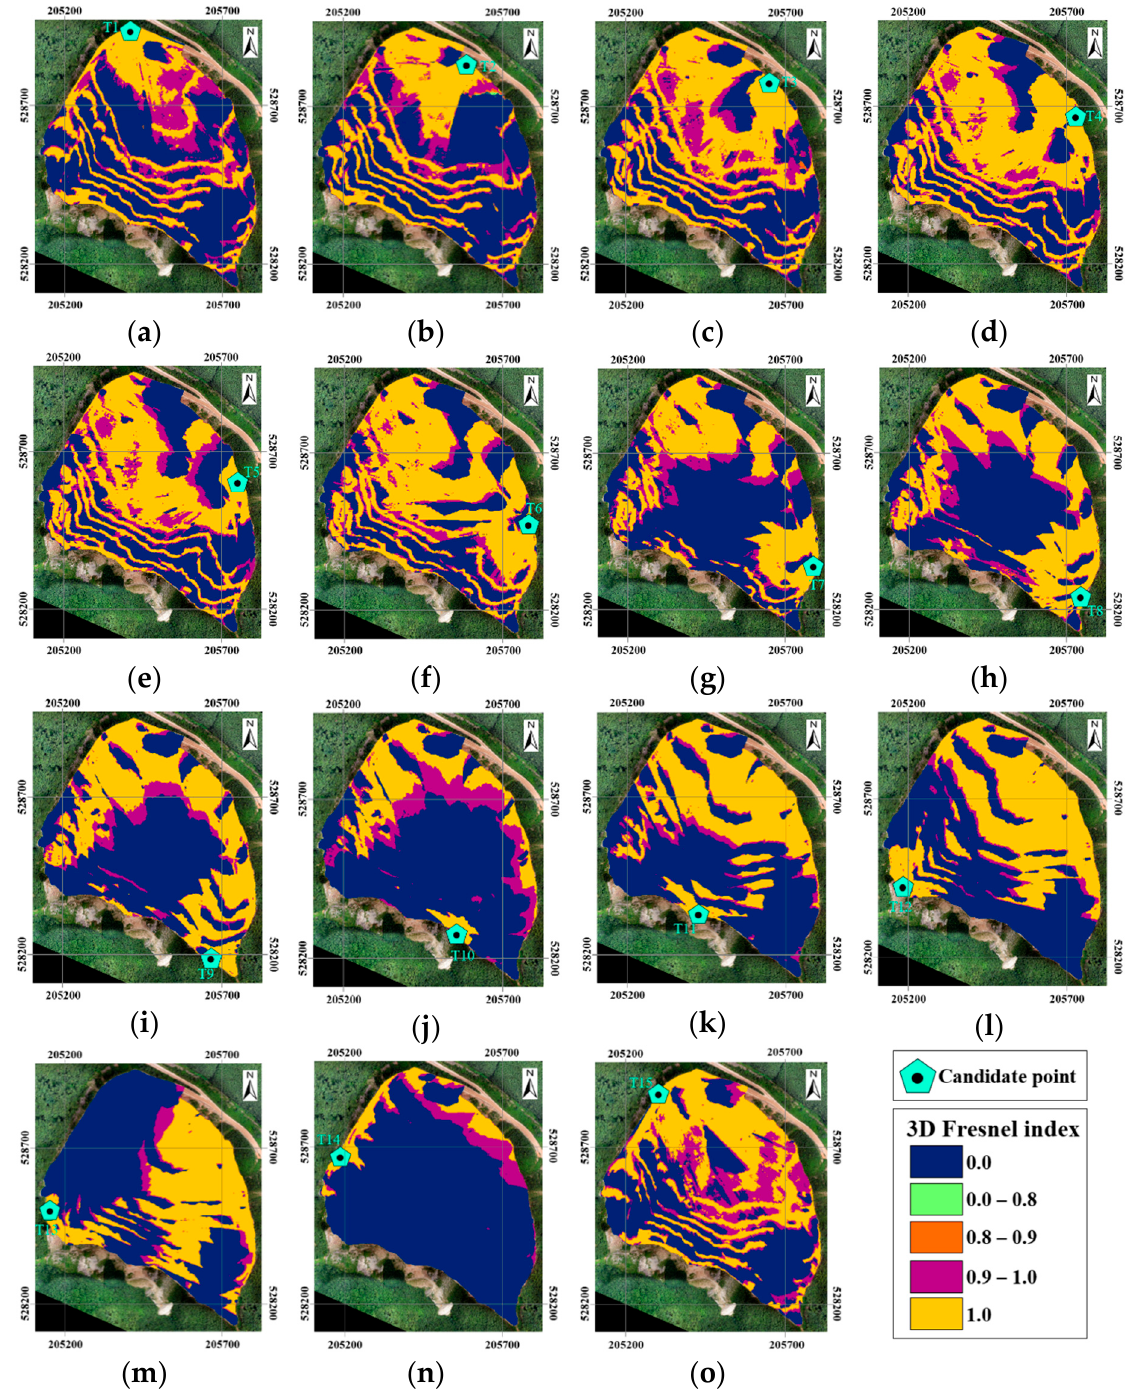
Figure 8. Three-dimensional Fresnel index maps of the open-pit mine for 15 candidate transmitter locations: ( a ) T1, ( b ) T2, ( c ) T3, ( d ) T4, ( e ) T5, ( f ) T6, ( g ) T7, ( h ) T8, ( i ) T9, ( j ) T10, ( k ) T11, ( l ) T12, ( m ) T13, ( n ) T14, ( o ) T15.